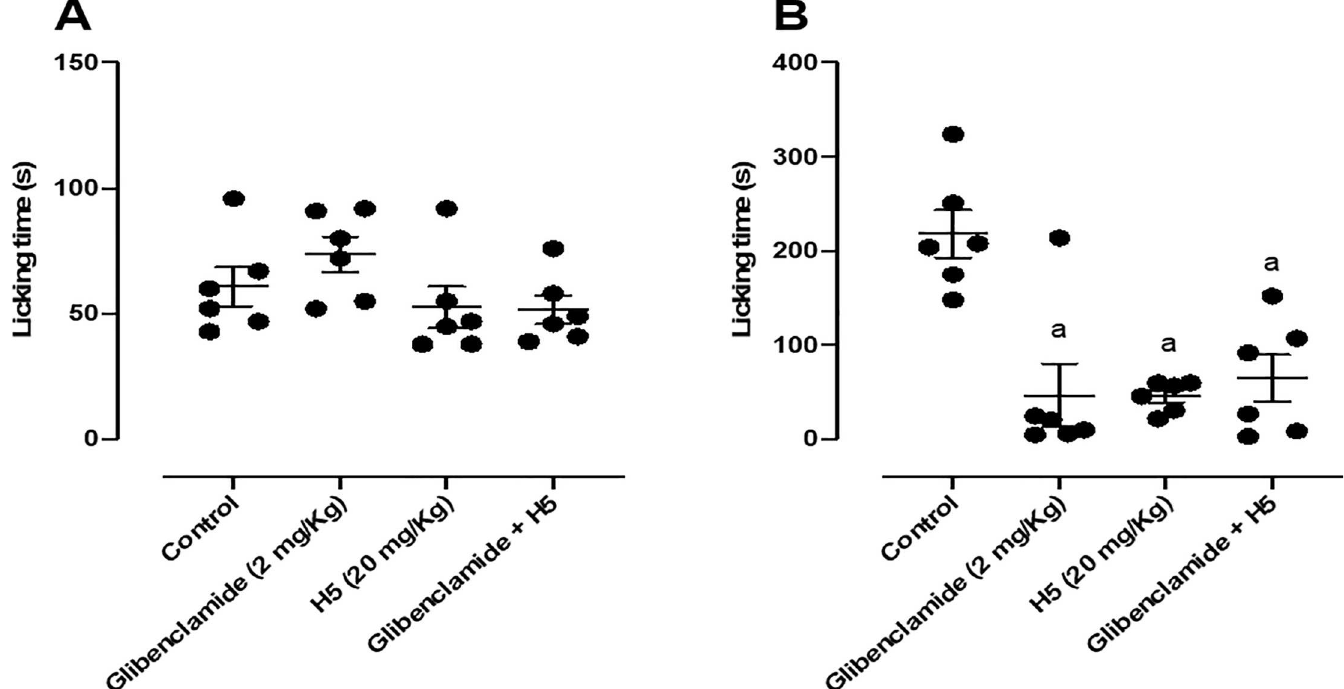
Fig 9. Effect of glibenclamide (2 mg/kg, i.p.), H5 (20 mg/kg, p.o.), glibenclamide + H5 in the first (A) and second (B) phases of the formalin-induced nociception test in mice (n = 6, per group). Values are expressed as the mean ± S.E.M., where a indicates p < 0.05 in comparison with control group, according to ANOVA, followed by Tukey’s post-test.